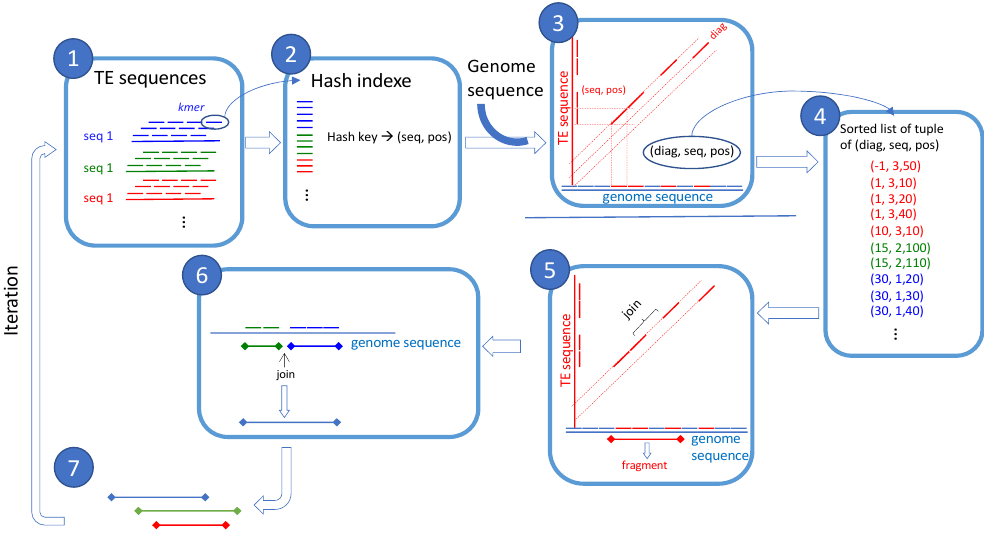
Figure 1 : Duster algorithm overview. 1- TE sequences are cut in overlapping kmer of length w. 2- Build a hash table from kmer hash value to store their positions and sequence numbers. 3- Search kmer on genome sequence that match a TE sequence kmer, record diagonal (difference of start sequence position) with TE sequence number and position on TE